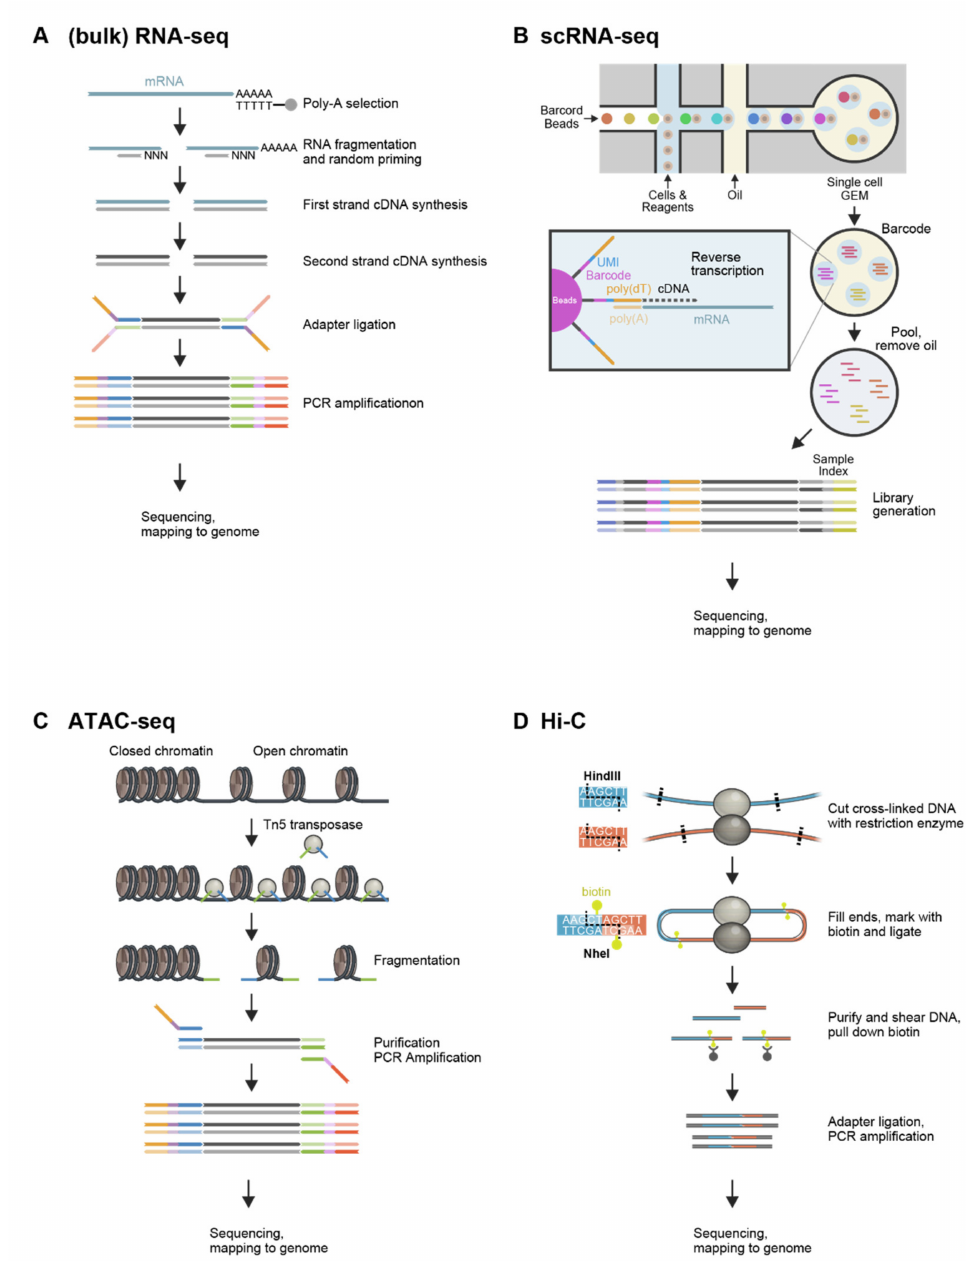
Figure 1. Overview of NGS analyses. ( A ) In (bulk) RNA-seq, poly-A-selected total RNA undergoes cDNA synthesis and adapter ligation, followed by PCR amplification. The resulting library is subjected to sequencing and mapping to the genome. ( B ) In scRNA-seq with 10 × Genomics Next GEM Technology, barcoded Gel Beads mixed with the cells, reagents, and partitioning oil within chromium instrument form GEMs (Gel Bead-in-emulsion) that contain a single cell. cDNAs are synthesized and barcoded in each GEM, then pooled to generate library for sequencing. ( C ) In ATAC-seq with a Tn5 transposase-based method, Tn5 transposases bind open chromatin regions and cut and ligate adaptors. After purification, PCR amplification, and sequencing, ligated adaptors are mapped to the genome. ( D ) In Hi-C analysis, formaldehyde generates cross-links between spatially adjacent DNA. After digestion with a restriction enzyme, the sticky ends are filled, marked with biotin, and ligated. The resulting DNA is purified, sheared, followed by isolation for biotin-marked DNA. Isolated DNA is subjected to sequencing and mapping to the genome